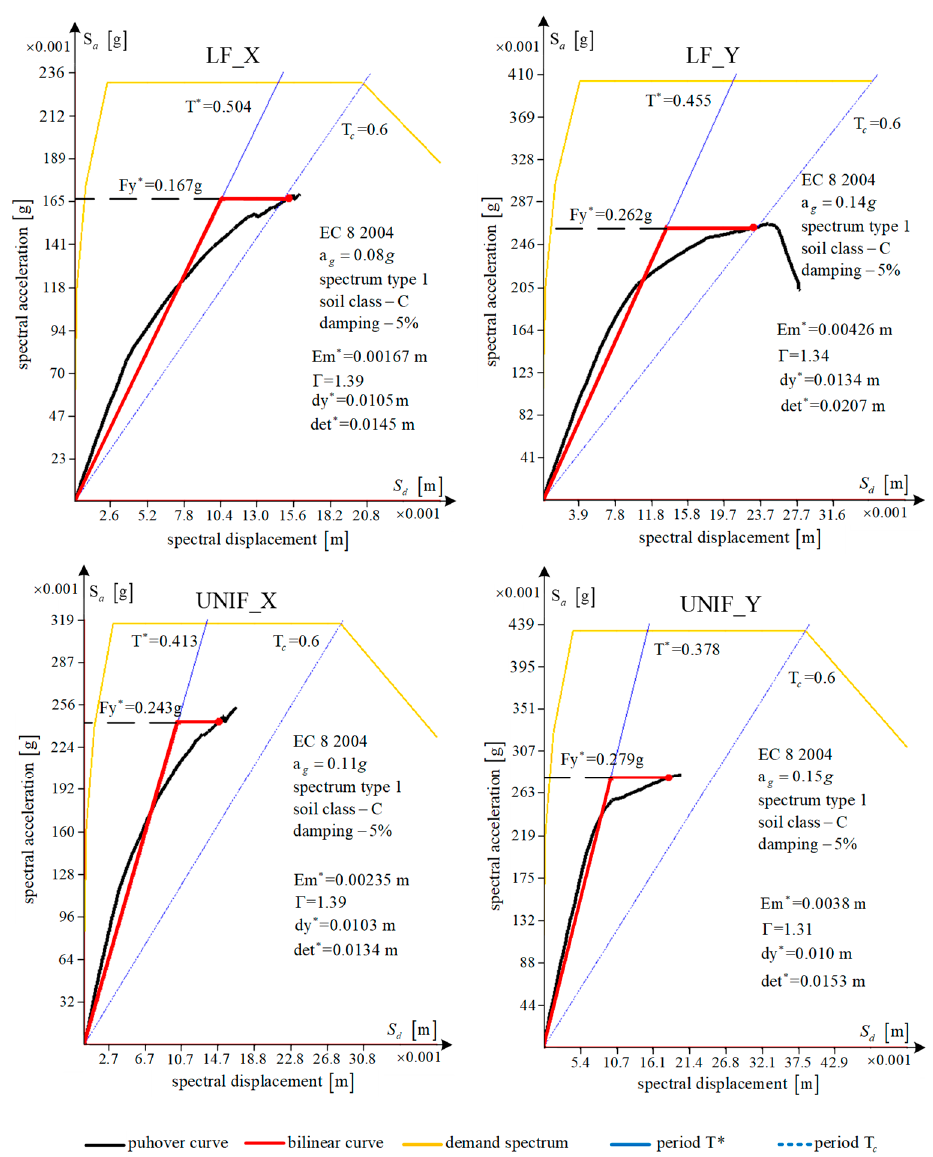
Figure 18. Capacity curves and displacement requirement of an equivalent 1DOF system.